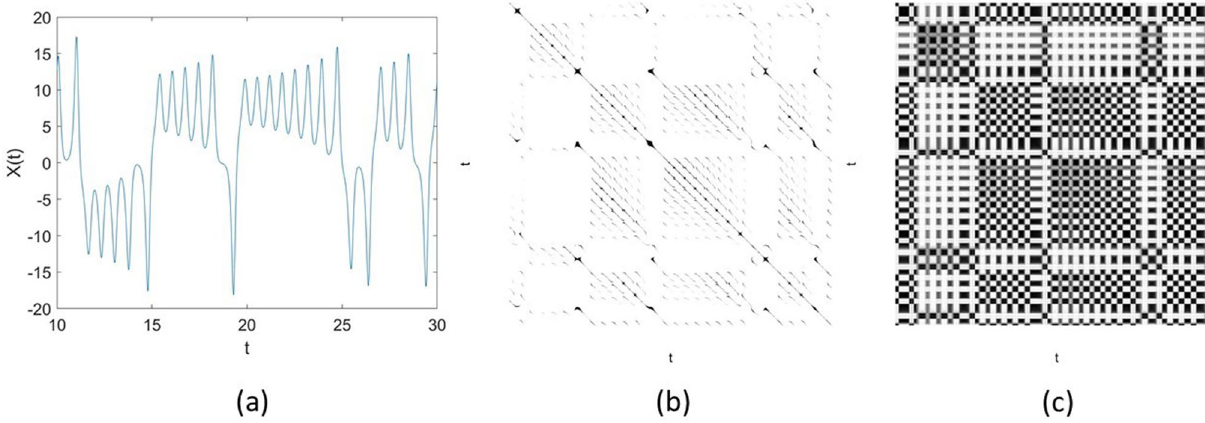
Figure 1. Recurrence of a dynamical system: ( a ) time series of the Lorenz X -component, ( b ) recurrence plot, and ( c ) fuzzy recurrence